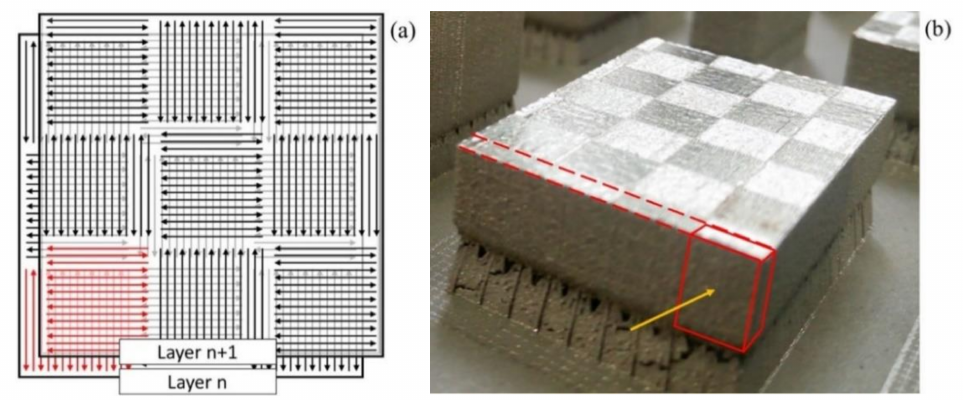
Figure 1. Island exposure strategy ( a ) and a piece produced by L-PBF ( b ). A typical sample used for plasma treatments, shown in ( b ) by continuous red lines, was obtained from slices (dashed red line) cut perpendicularly to the built surface. The surface exposed to plasma is indicated by the yellow